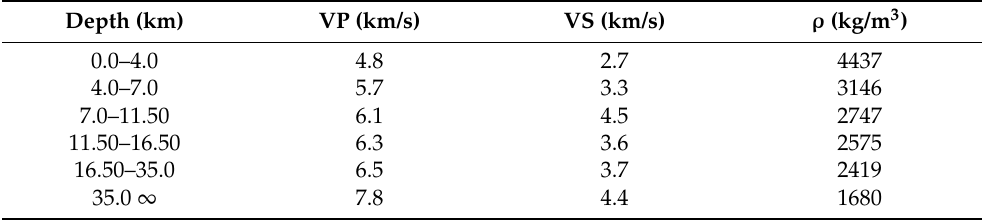
Table 1. Structural model used to relocate the TSS sequence and to compute Coulomb stress change. VP = P-wave velocity, VS = S-wave velocity, ρ = density. The density was computed from vs. assuming a shear modulus of 33